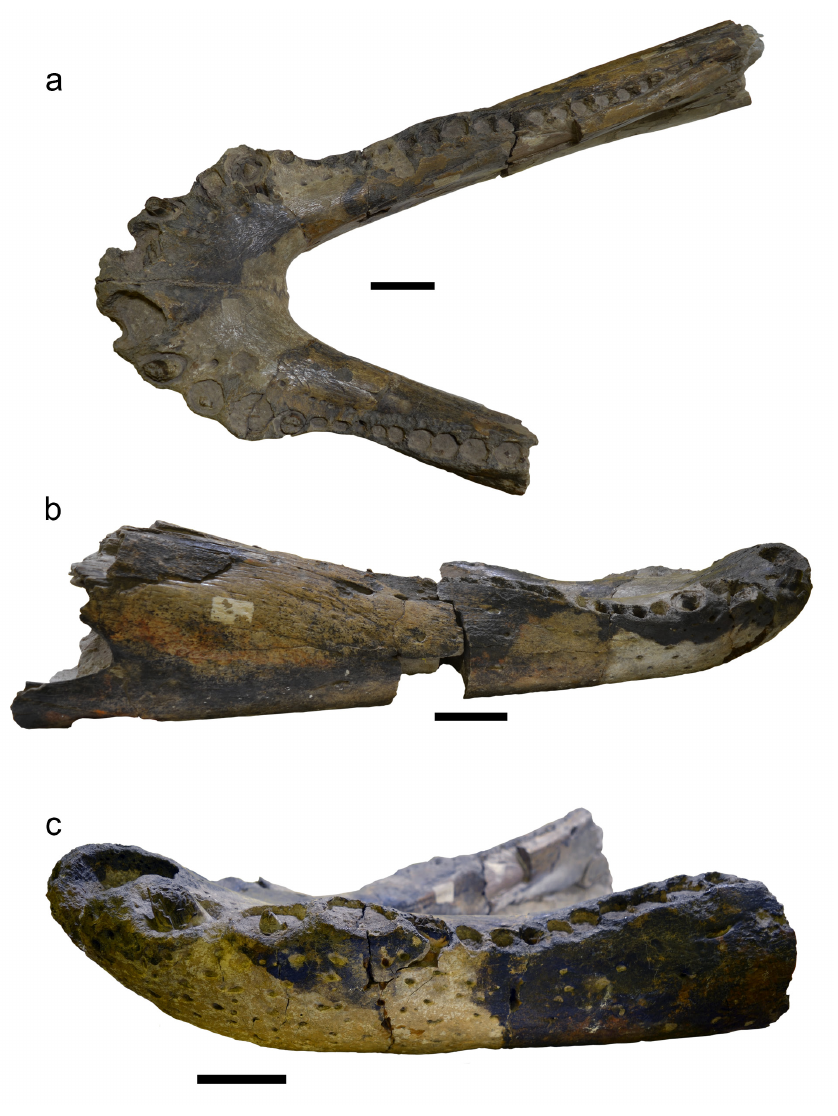
Figure 4. The mandible specimen of Purussaurus brasiliensis (DGM 527-R). a) ; b) medial view of